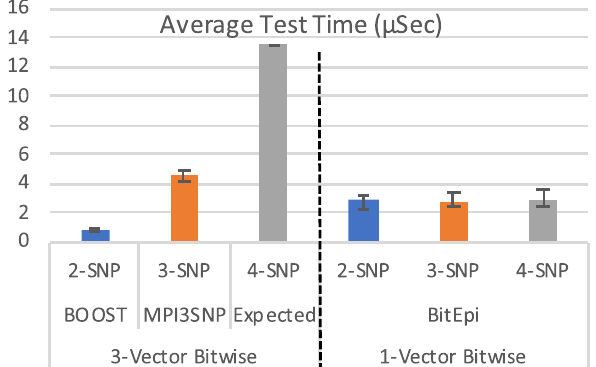
Figure 3. The average runtime per test for 2, 3, and 4-SNP interactions, comparing the 3-Vector bitwise approach (left) with BitEpi’s 1-Vector bitwise approach (right). The expected 4-SNV average test time with the 3-Vector bitwise approach is computed as MPI 3 SNP × 3 . The average test time is computed based on the highlighted execution time in Table 2. Error bars represent standard